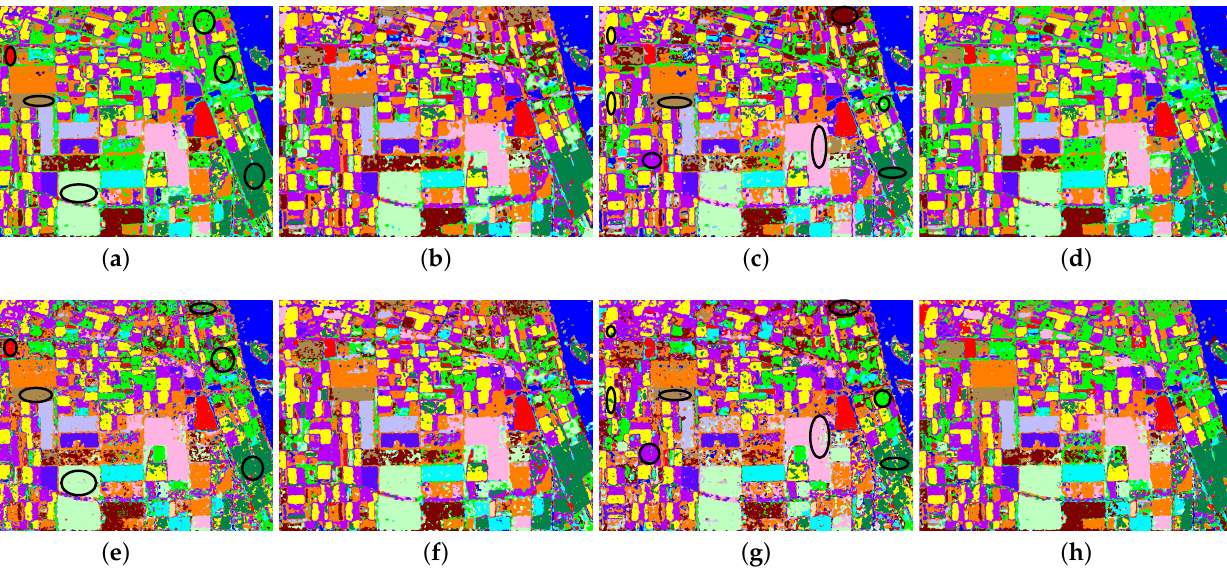
Figure 8. Prediction result of Flevoland image obtained by different methods, including ( a ) SVM on the learned parameters, ( b ) SVM on all the parameters, ( c ) ANN on the learned parameters, ( d ) ANN on all the parameters, ( e ) AE on the learned parameters, ( f ) AE on all the parameters, ( g ) AEFT on the learned parameters, and ( h ) AEFT on all the